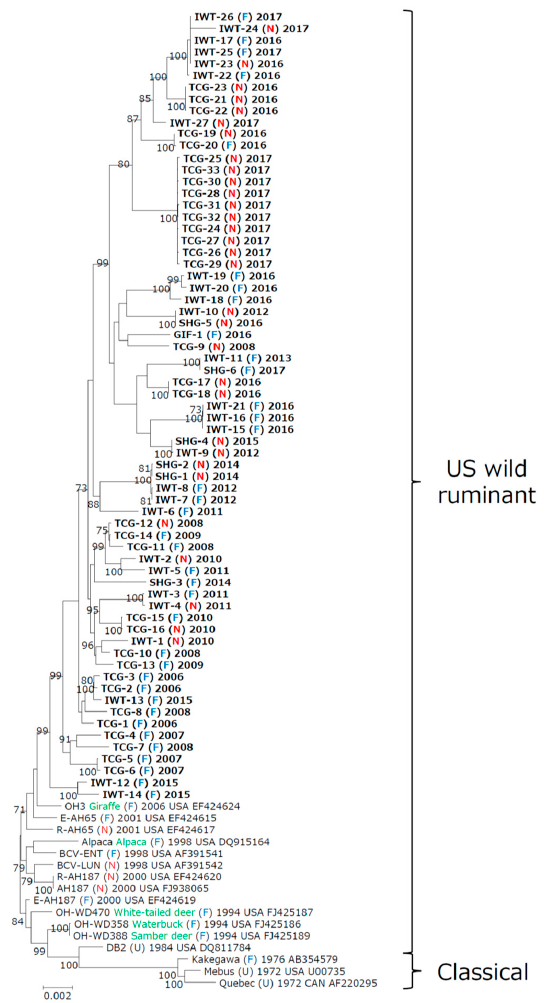
Figure 1. Phylogenetic tree constructed using whole genomes of 67 recent bovine coronavirus (BCoV) isolates from Japan and 16 reference BCoV strains from other countries. The tree was constructed using the maximum-likelihood method with the general time reversible nucleotide substitution model implemented in the MEGA X program. Numbers at each branch represent groups with > 70% bootstrap support using 1000 replicates. Strain name, host (green): in case of wild ruminant, source: fecal sample (F), nasal swab (N), and unknown (U), year of collection, country, and the GenBank accession number are indicated. Bold text represents the Japanese BCoV isolates used in this study. The scale bar indicates nucleotide substitutions per